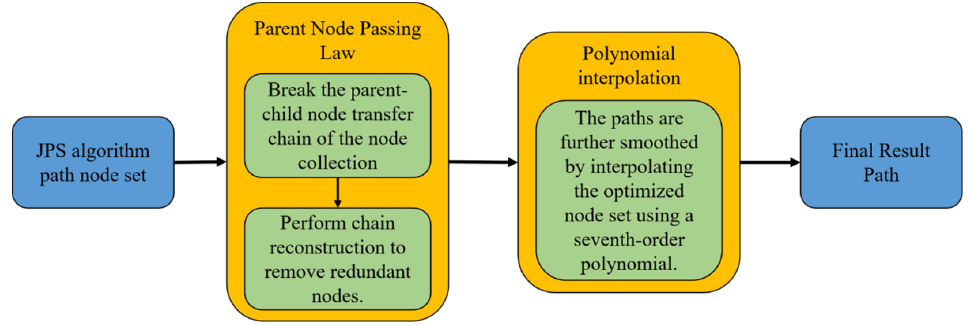
Figure 9. Trajectory optimization framework.